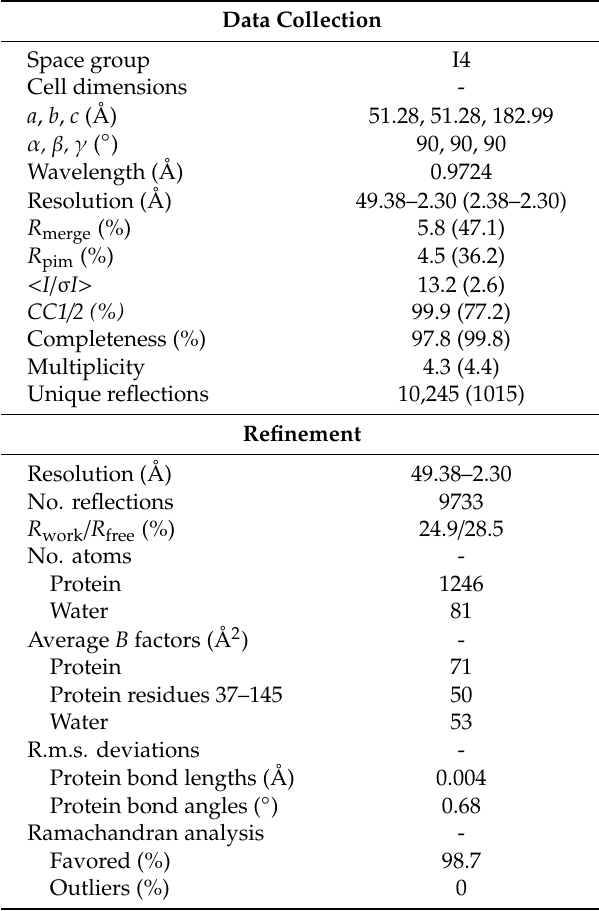
Table 1. Crystallographic data collection and refinement statistics. R.m.s.: root mean square Data